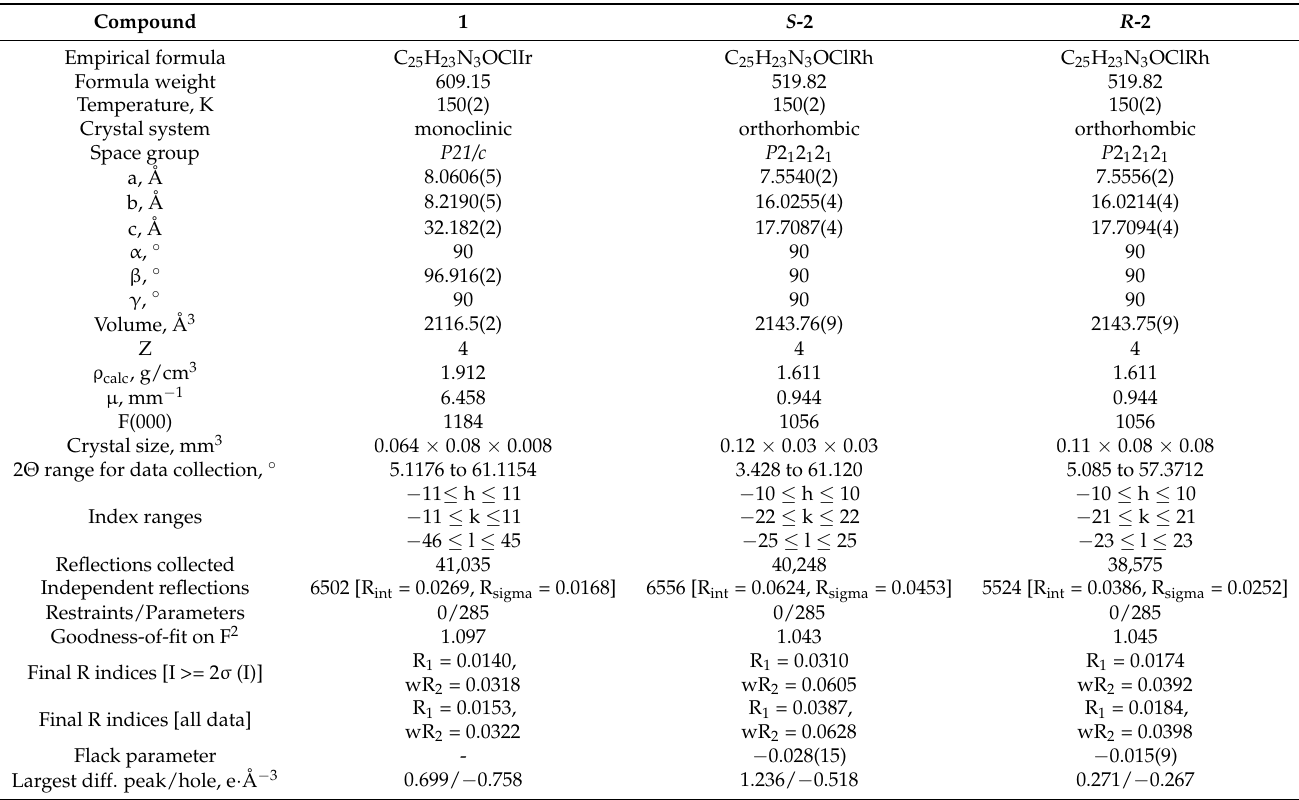
Table 1. Crystallographic data of compounds 1 – 2